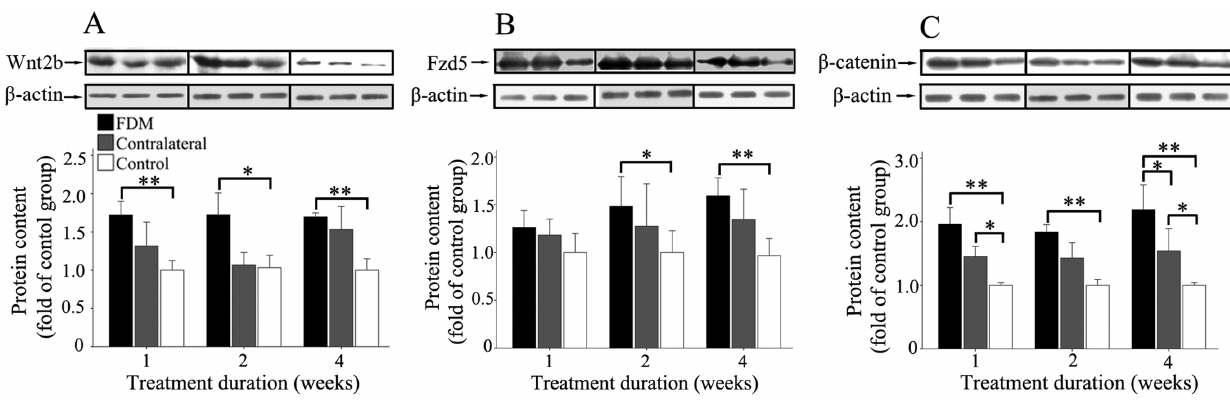
Figure 4. Form deprivation increased the retinal content of Wnt2b, Fzd5 and b -catenin proteins. (A) Wnt2b protein content in the FDM group was significantly greater than that in the control group, at 1, 2 and 4 weeks. (B) Fzd5 protein content in the FDM group was significantly greater than that in the control group, at 2 and 4 weeks. (C) Nuclear b -catenin protein content was significantly higher in the FDM group than in the control group at 1, 2 and 4 weeks. Significant differences between FDM eyes and contralateral eyes also were found at 4 weeks, and content was significantly higher in the contralateral eye group than in the control group at 1 and 4 weeks. Retinas from both eyes of fourteen FDM mice and 9 control mice were used for each treatment duration. Data are presented as mean 6 SEM. (* P , 0.05 and ** P ,